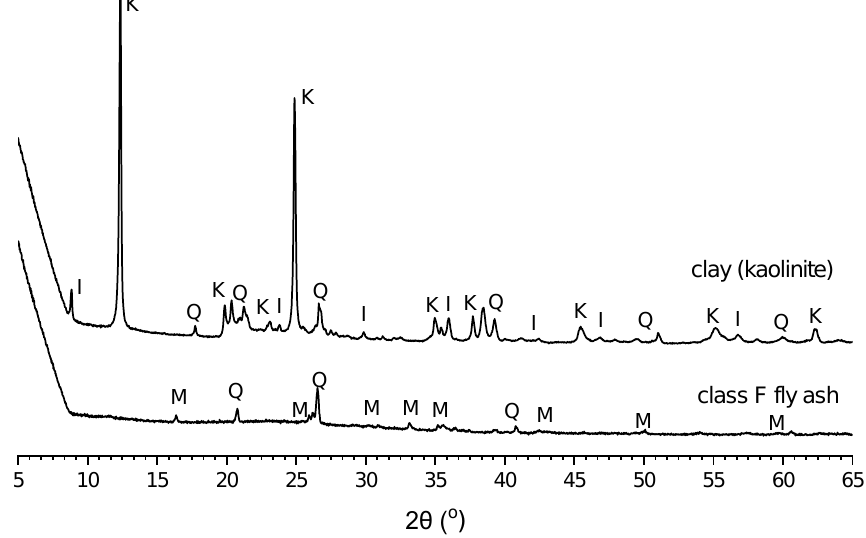
Figure 10. XRD patterns of clay and class F fly ash; I = illite, K = kaolinite, Q = quartz, M = mullite.